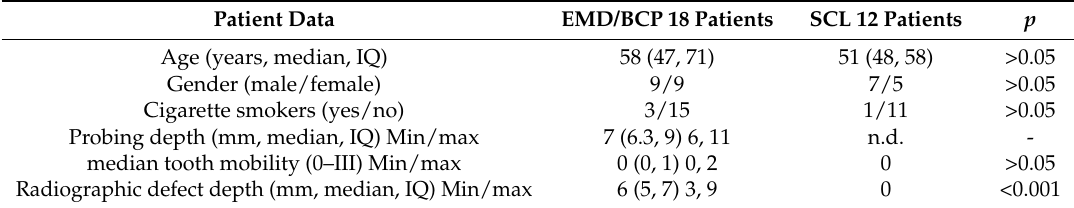
Table 1. Demographic and clinical patient characteristics at baseline. EMD/BCP: enamel matrix derivative/biphasic calcium phosphate; SCL: surgical crown lengthening. IQ: inter-quartiles. n.d.: Not Detected. Patient Data